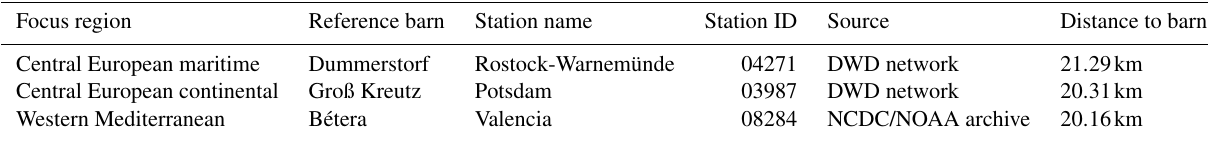
Table 2. Stations and sources for meteorological outdoor data. Focus region